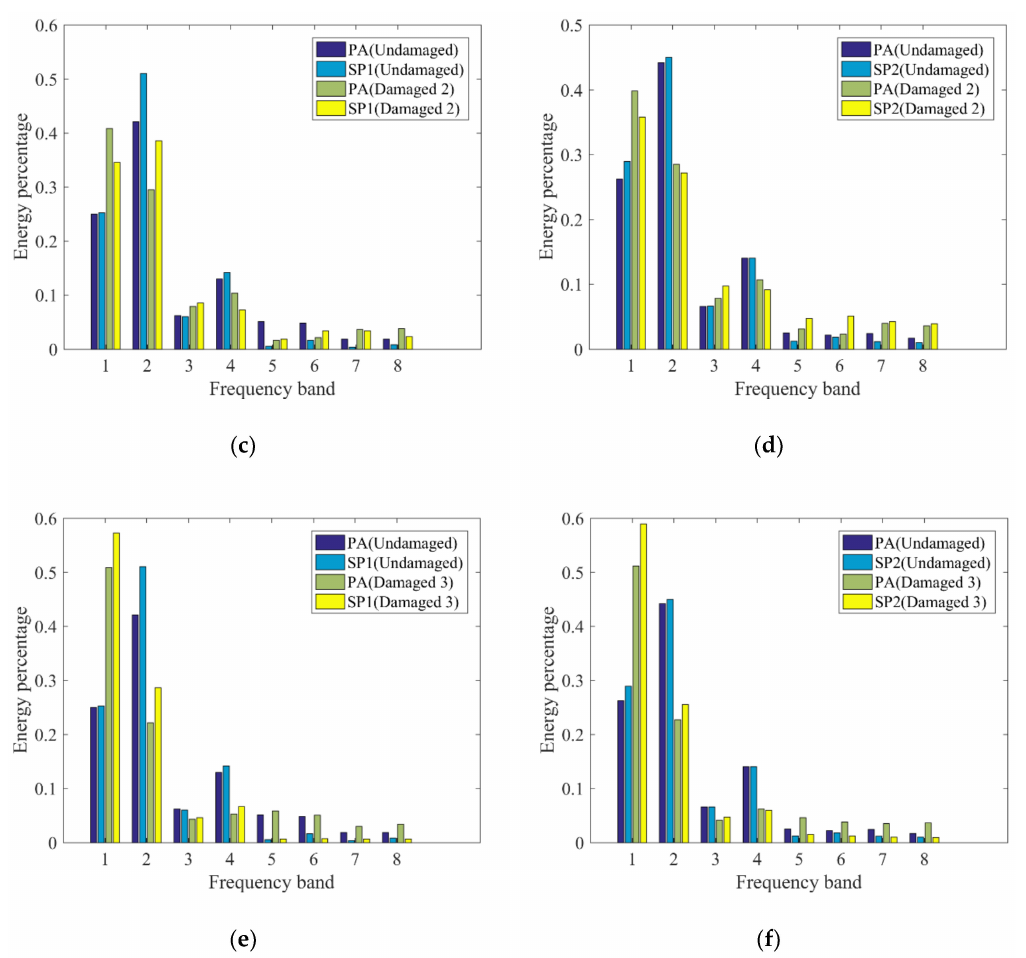
Figure 10. p j calculated for ( a ) frame 1 and ( b ) frame 2 in the damaged 1 case, ( c ) frame 1 and ( d ) frame 2 in the damaged 2 case, and ( e ) frame 1 and ( f ) frame 2 in the damaged 3 case when structure is subjected to Nr-1 cm